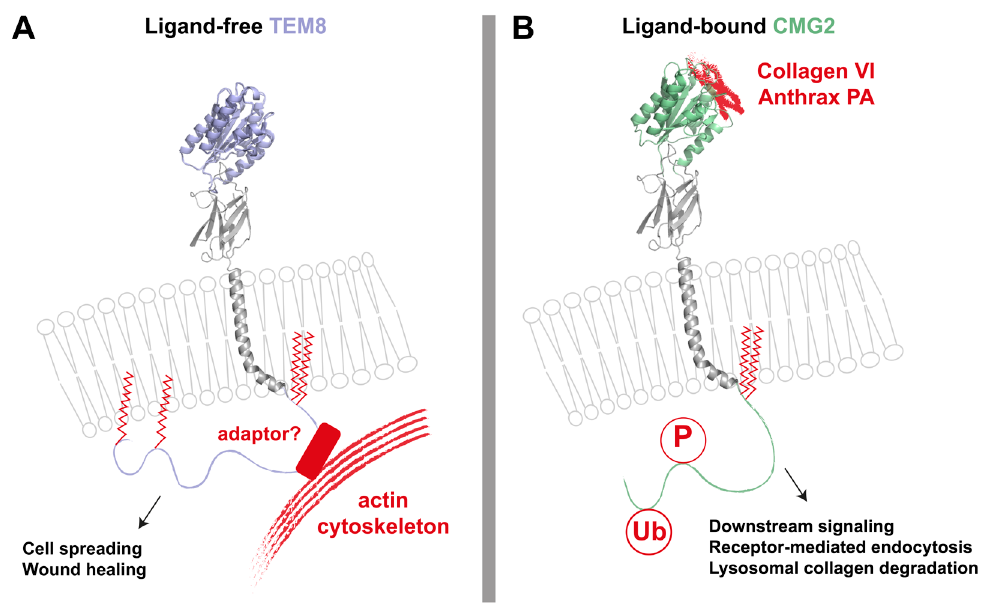
Figure 2. Depictions of ligand-free TEM8 and ligand-bound CMG2. ( A ) Ligand-free tumor endothelial marker 8 (TEM8) is palmitoylated and bound directly or indirectly to the actin cytoskeleton. Through this association, it plays a role in cell spreading and migration as well as wound healing. Red zigzag lines represent S-palmitoylation modifications of TEM8, which increase resident time of either receptor at the cell surface. ( B ) When bound to collagen VI (ColVI) or anthrax toxin protective antigen (PA), capillary morphogenesis gene 2 (CMG2) becomes phosphorylated (“P”) and ubiquitinated (“Ub”). This allows CMG2 to signal downstream within the cell, endocytose the receptor–ligand complex, and degrade ColVI in the